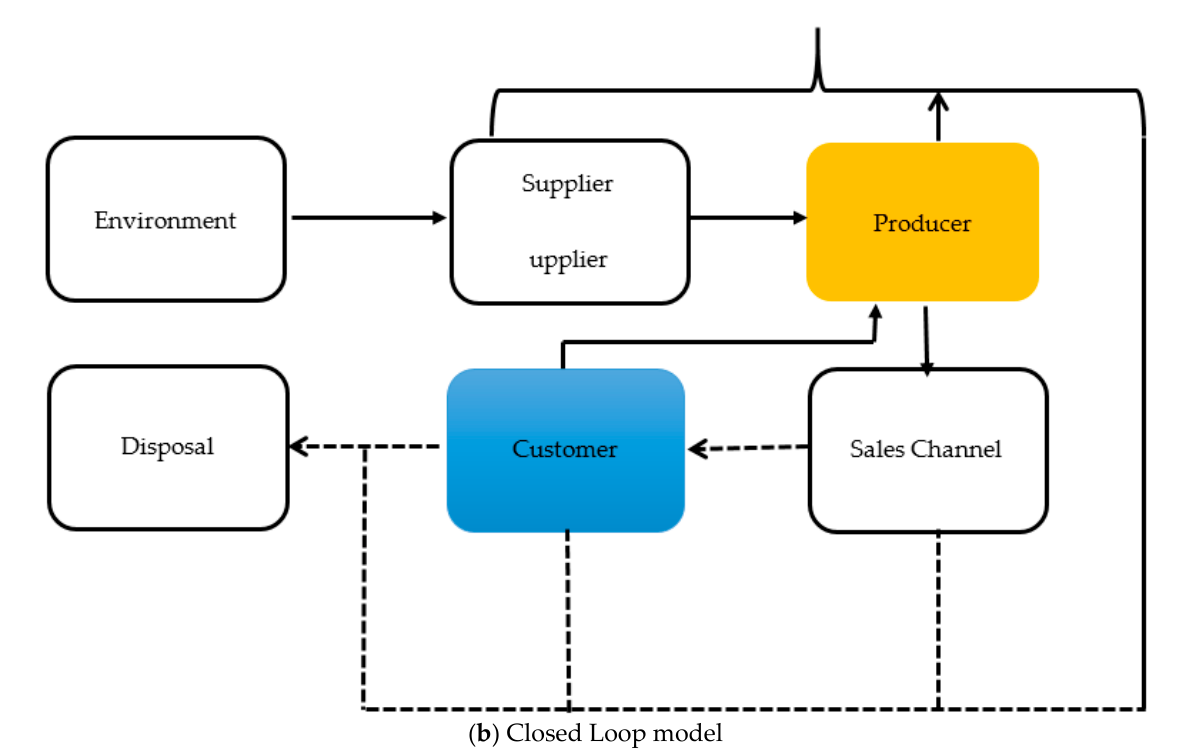
Figure 1. Structure of different supply chain models.